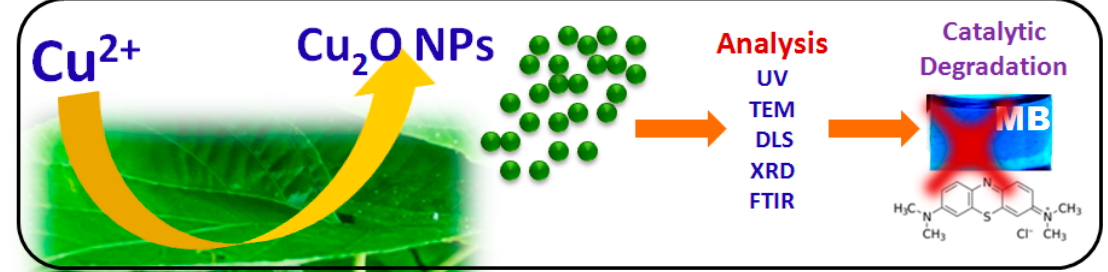
Figure 1. Schematic presentation of the synthesis and application of Cu 2 O nanoparticles.